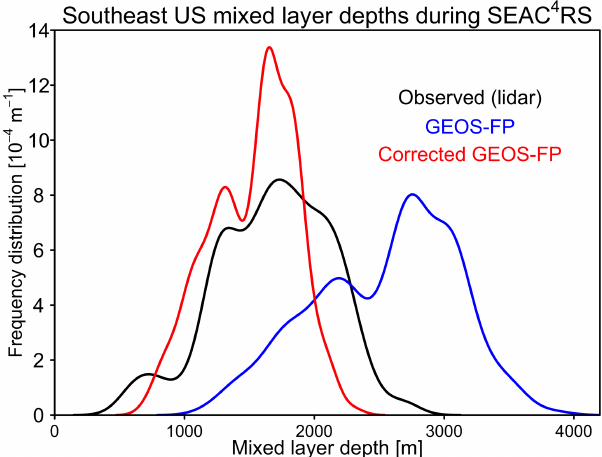
Figure 4. Frequency distribution of mixed layer depths over the southeast US during the SEAC 4 RS period (5 August–25 Septem- ber 2013). Observations by aerosol lidar aboard the aircraft (DIAL- HSRL Mixed Layer Heights README, 2014) are compared to the local GEOS-FP data used to drive GEOS-Chem, before and after the 40% downward correction. The frequency distributions are con- structed from 1min average data along the aircraft flight tracks over the southeast US (box in Fig. 1) for the 12:00–17:00LT